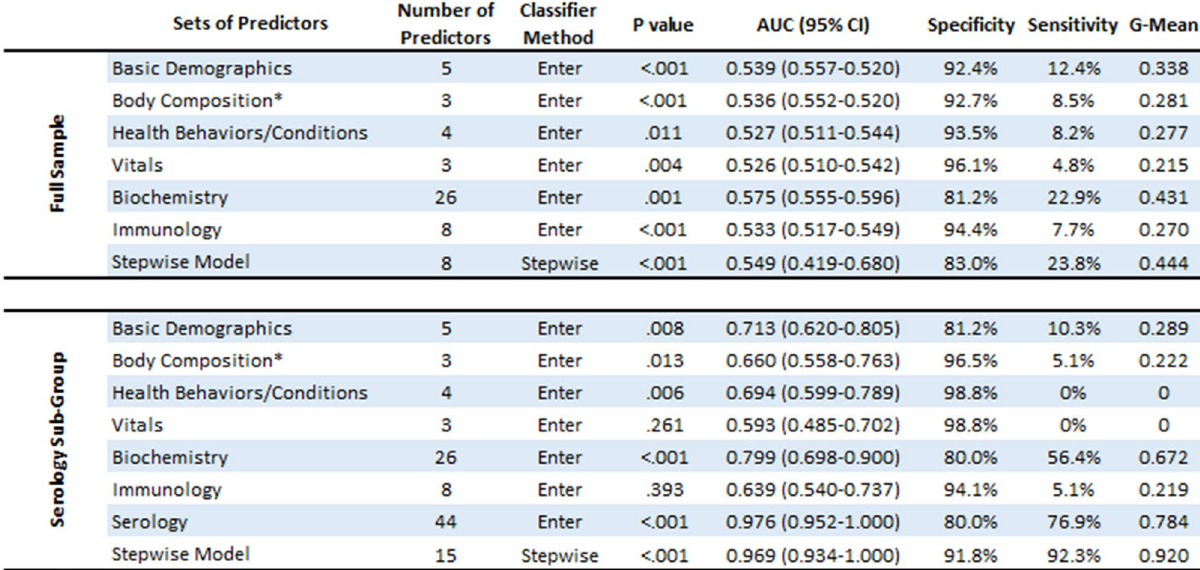
Table 8, this model had only 2 predictors: antibody response to two antigens for two diseases (HTLV-1 gag for HTLV-1 and JC VP1 for Human Polyomavirus JCV). Discussion